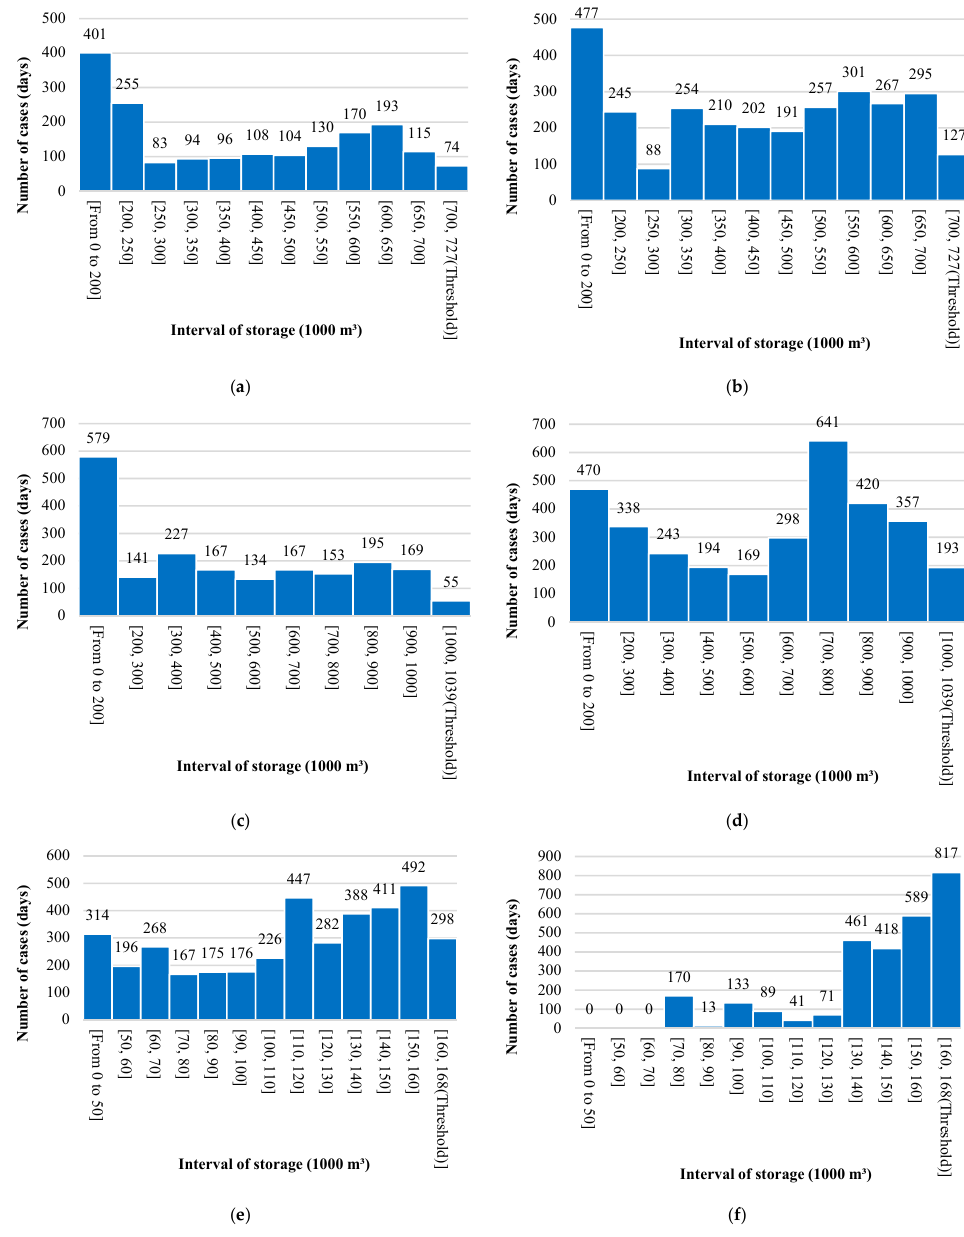
Figure 9. Histograms of simulated reservoir water storages below threshold level in Kicheon, Deokwoo, and Samchun reservoirs from 2008 to 2099 before and after calibration. ( a ) Before calibration (Kicheon reservoir); ( b ) after calibration (Kicheon reservoir); ( c ) before calibration (Deokwoo reservoir); ( d ) after calibration (Deokwoo reservoir); ( e ) before calibration (Samchun reservoir); ( f ) after calibration (Samchun reservoir). For the Kicheon reservoir, the average daily water volume in the 10-year drought period was 727,000 m 3 . Without calibration, the simulation results show that the water volume will decrease